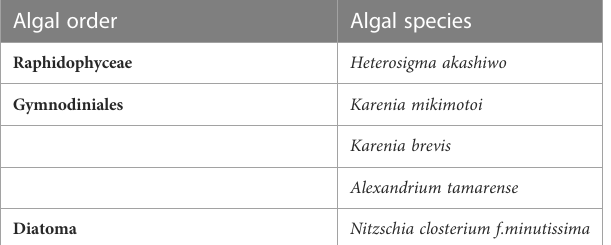
TABLE 1 Red tide algal species used in this